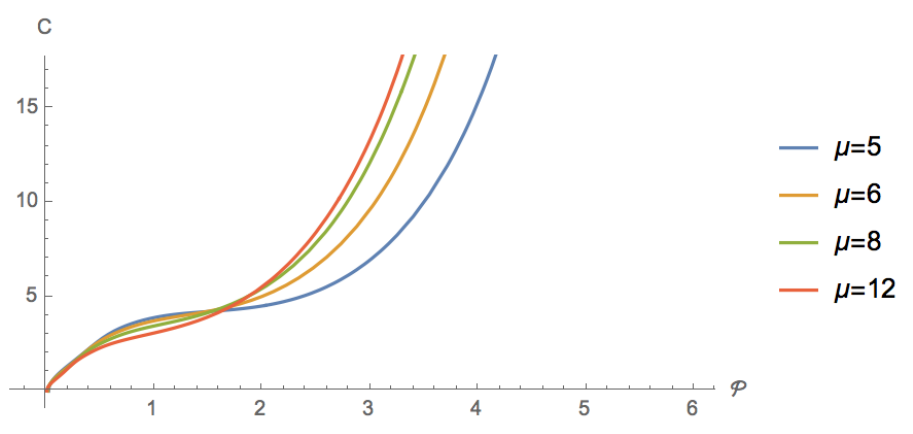
Figure 6 . Deformed hyperbolic black holes for (cid:12)xed (cid:23) = 4. The values of (cid:22) shown include points in both D3 and